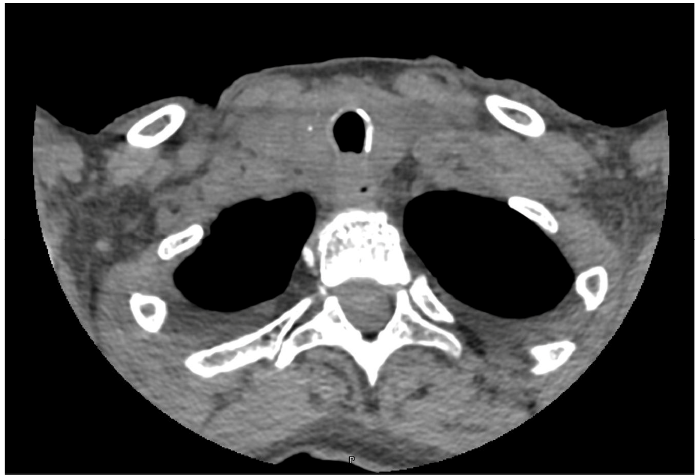
Figure 2. CT of the neck demonstrating narrowing of the cervical portion of the esophagus by TM.